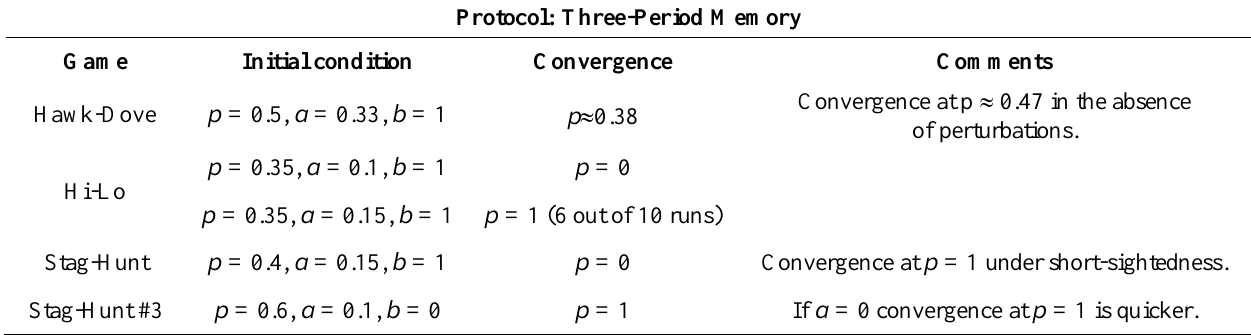
Table 5. Simulation results for three-period memory protocol with stochastic perturbations. Protocol: Three-Period